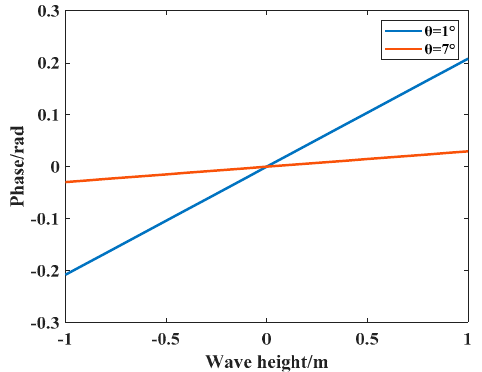
Figure 12. Change in elevation phase at near and far range (in rad). The blue line shows the change of phase with elevation when the incident angle is 1 ◦ , and the red line shows the change of phase with elevation when the incident angle is 7 ◦